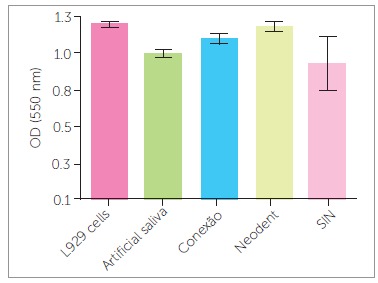
MTT colorimetric assay for L929 cell samples incubated with extract solutions of mini-implants obtained after 60 days of immersion in artificial saliva.